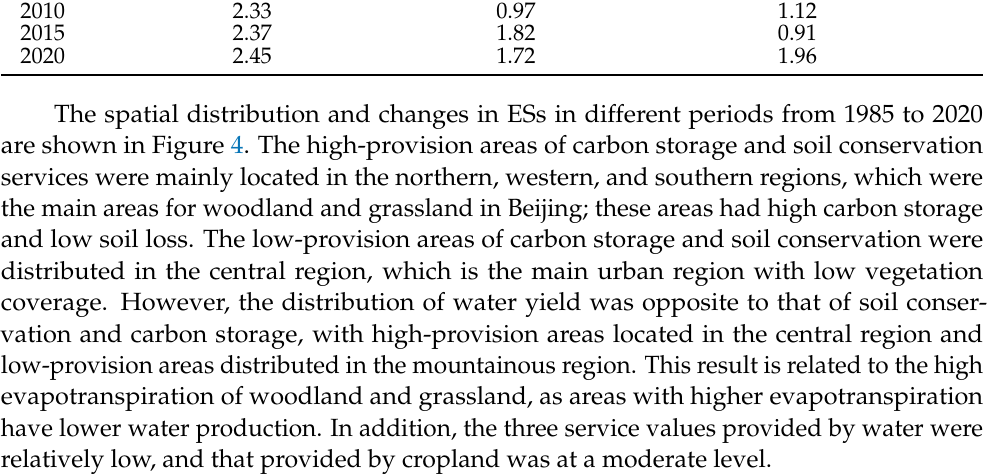
Water Yield (10 9 m 3